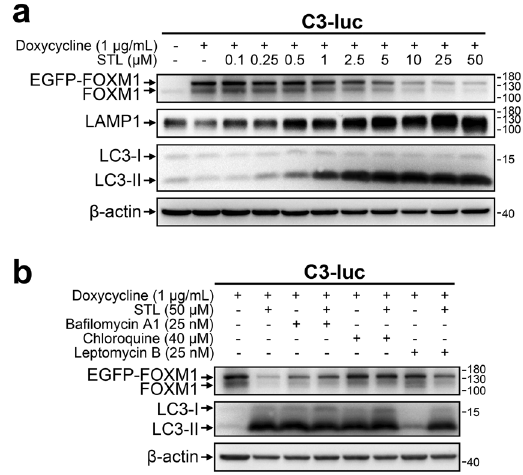
Fig. 3 STL-dependent FOXM1 degradation is autophagy- mediated and is prevented by nuclear-export arrest. a C3-luc cells were treated with indicated concentrations of doxycycline and STL for 24 h. Total protein samples were analyzed via immunoblot- ting for FOXM1, LAMP1, and LC3 expression, β -actin was used as an internal loading control. b C3-luc cells were treated with indicated concentrations of doxycycline, STL, ba fi lomycin A1, CQ, and LMB for 24 h. Total protein samples were analyzed via immunoblotting for FOXM1 and LC3 expression, β -actin was used as an internal loading